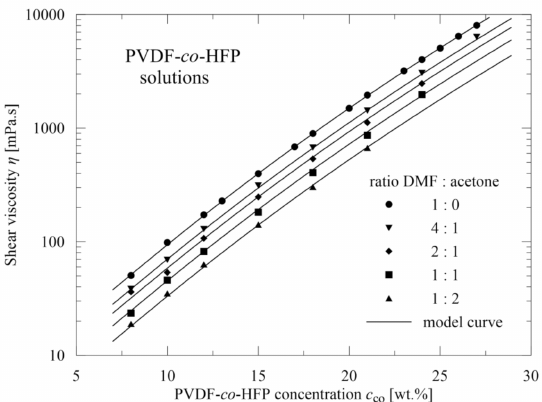
Figure 4. Viscosity measurements for various copolymer concentrations and DMF/acetone